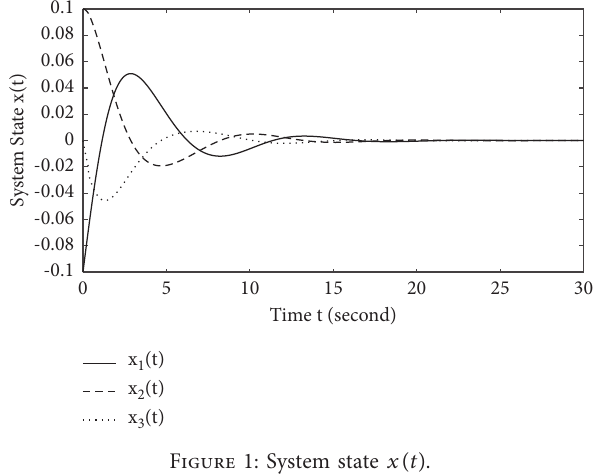
Figure 1: System state x ( t ) .